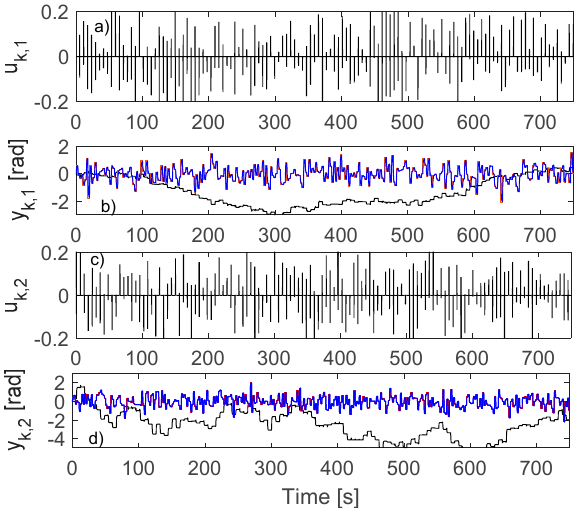
m (blue), r (red); ( c ) u k ,2 ; ( d ) y k ,2 k ,1 k ,1